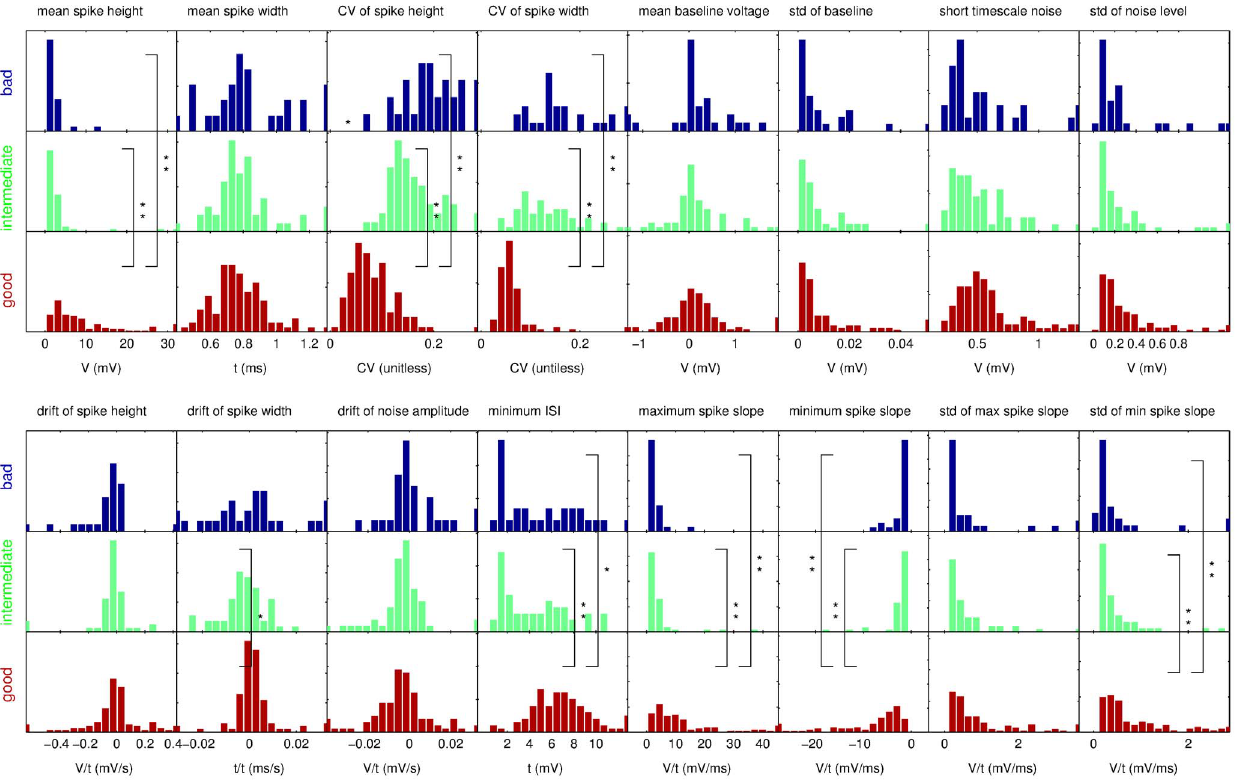
Figure 2. Overview of the observed distributions of feature values for data set 1. The value distributions are shown separately for recordings that were classified as good (red), intermediate (green) or bad (blue) by expert 1. We have compared the distributions with Kolmogorov- Smirnov tests and found that many but not all distributions differ significantly on significance level a =0.05 (one star) or a =0.01 (two stars). We note that the distributions between intermediate and bad recordings rarely differ significantly but often both do differ from the good